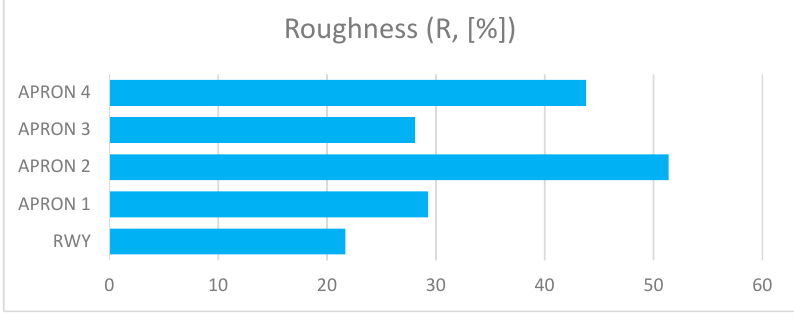
Figure 8. Roughness of AFE’s.